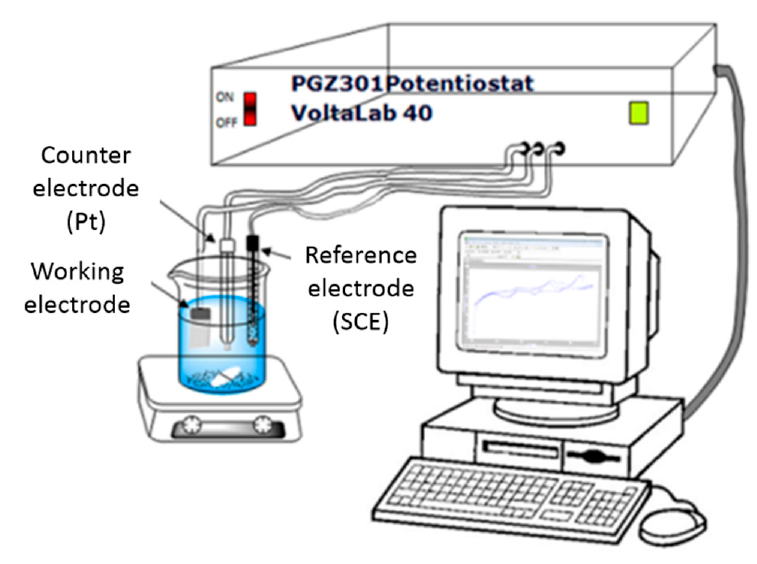
Figure 1. The three-electrode cell connected to the potentiostat.